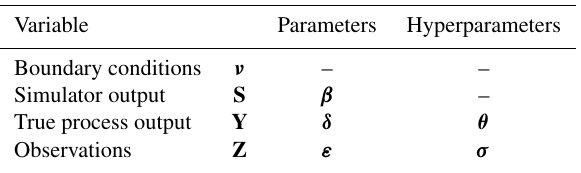
Table 1. Summary of variables, parameters, and hyperparameters in the uncertainty